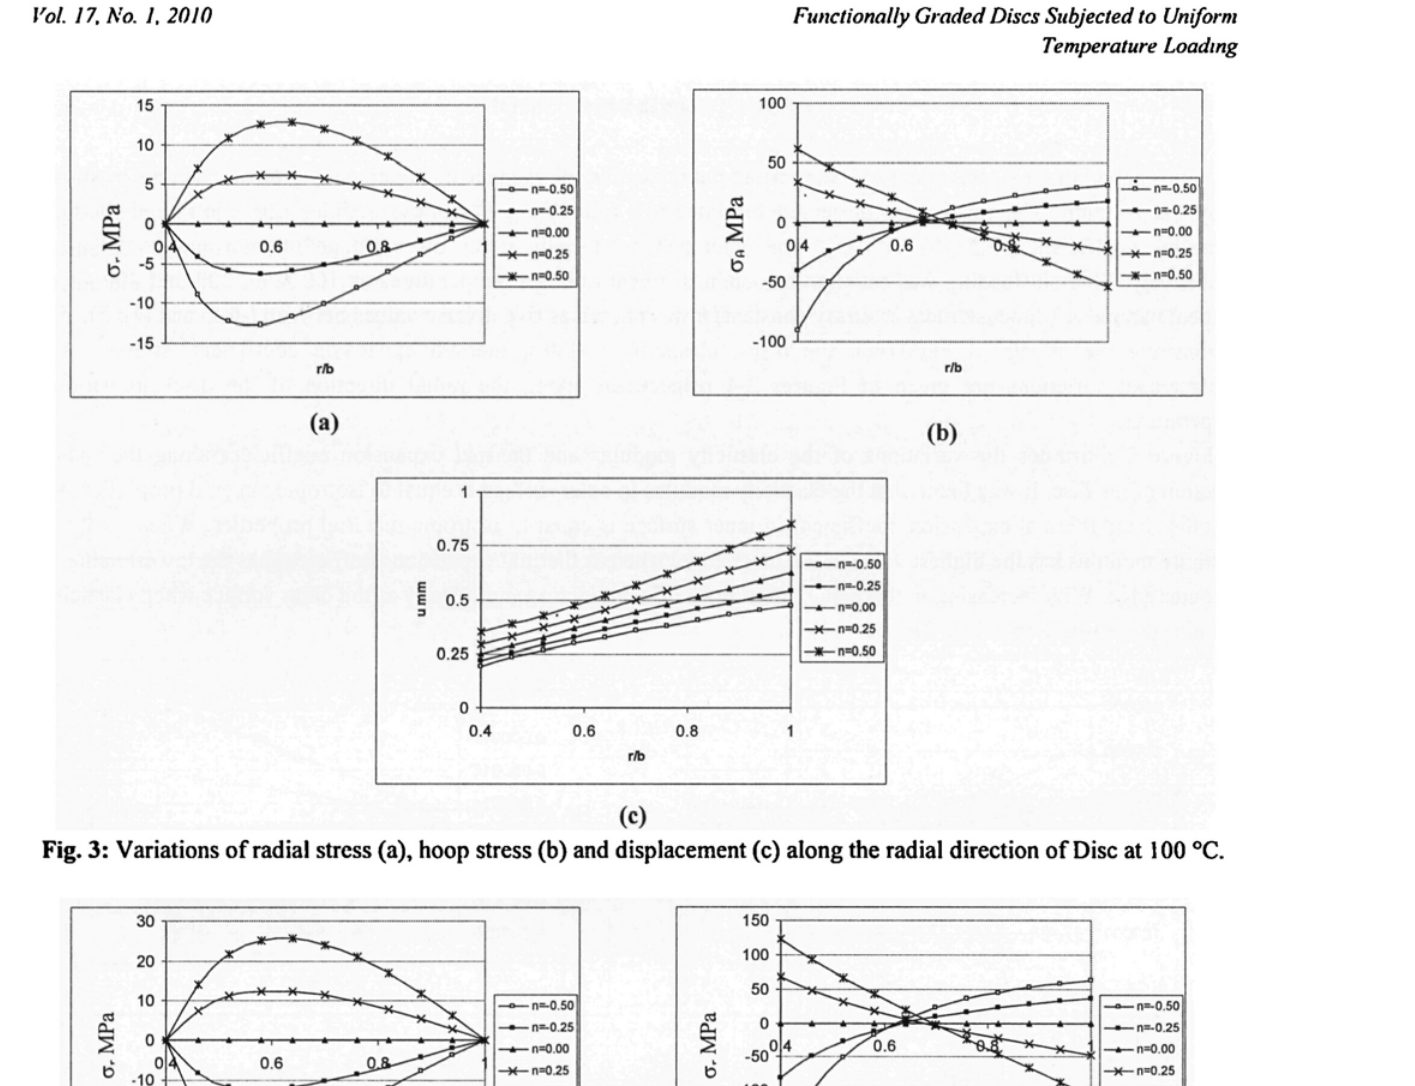
Fig. 3: Variations of radial stress (a), hoop stress (b) and displacement (c) along the radial direction of Disc at 100 °C.